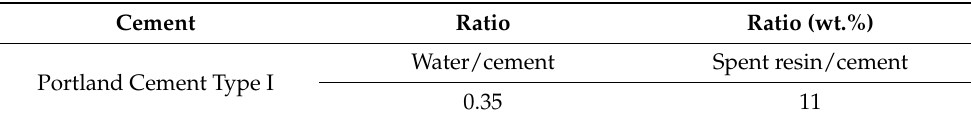
Table 7. Components of cement waste forms fabricated using the optimal operating conditions and their respective ratios.